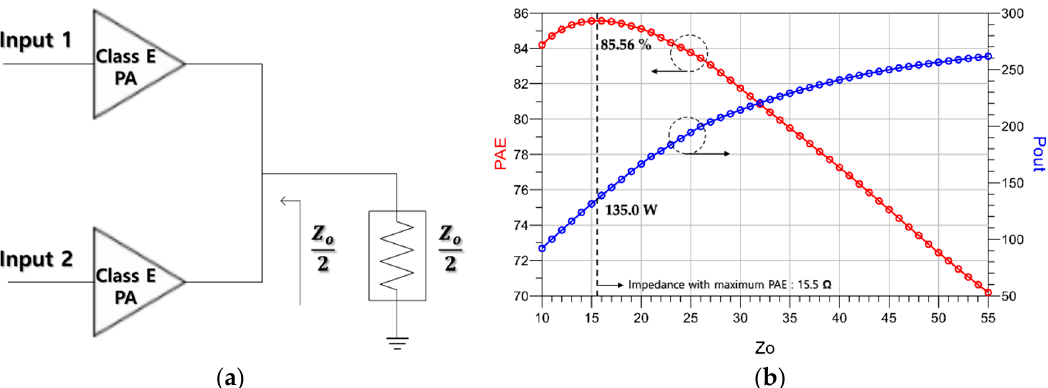
Figure 3. Two class-E power amplifiers connected with the optimum load impedance Z o : ( a ) Block diagram of the amplifiers; ( b ) simulation results of the two PAs with the direct connection to the optimum load.